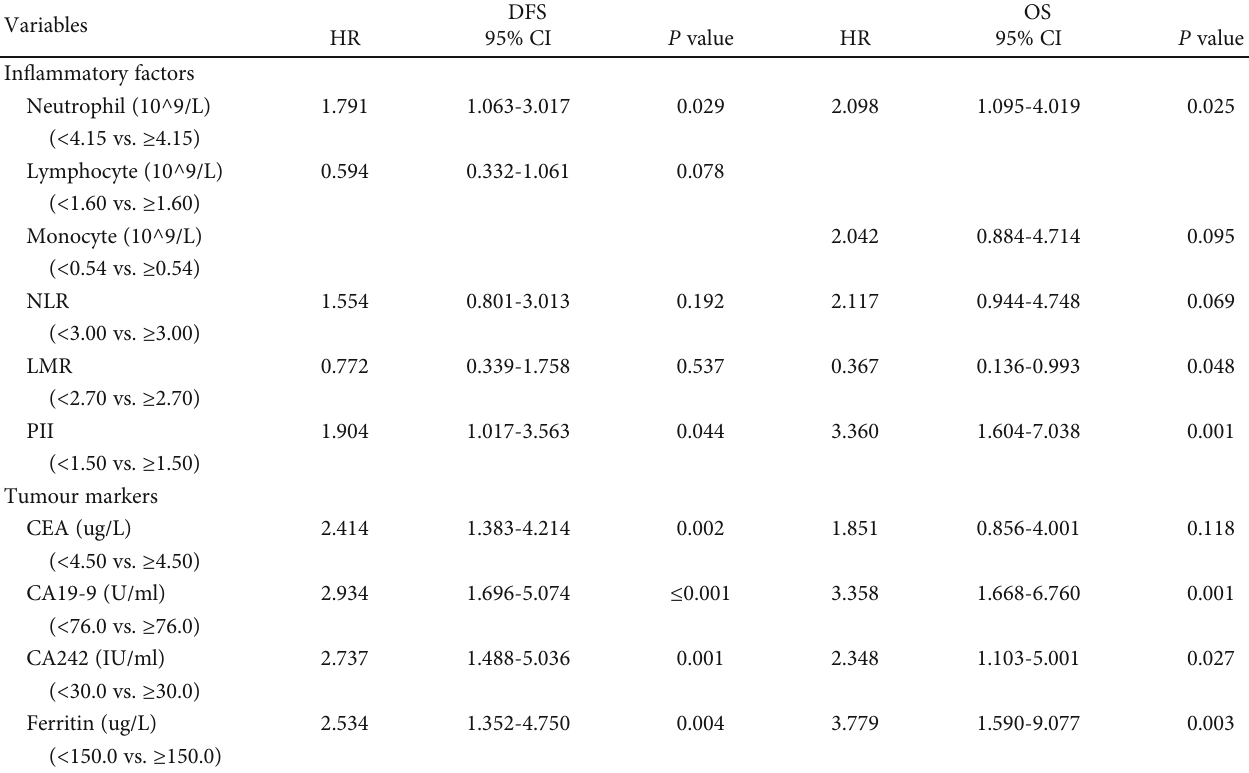
Table 2: Multivariate analysis of prognostic factors for ICC in the training